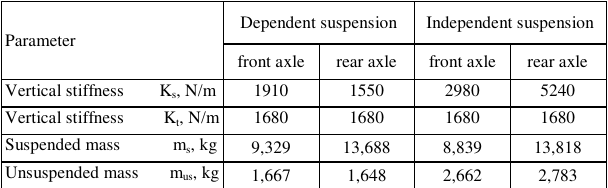
Table 1. Comparison of parameters of the vehicle physical model equipped with various types of suspension [own research]